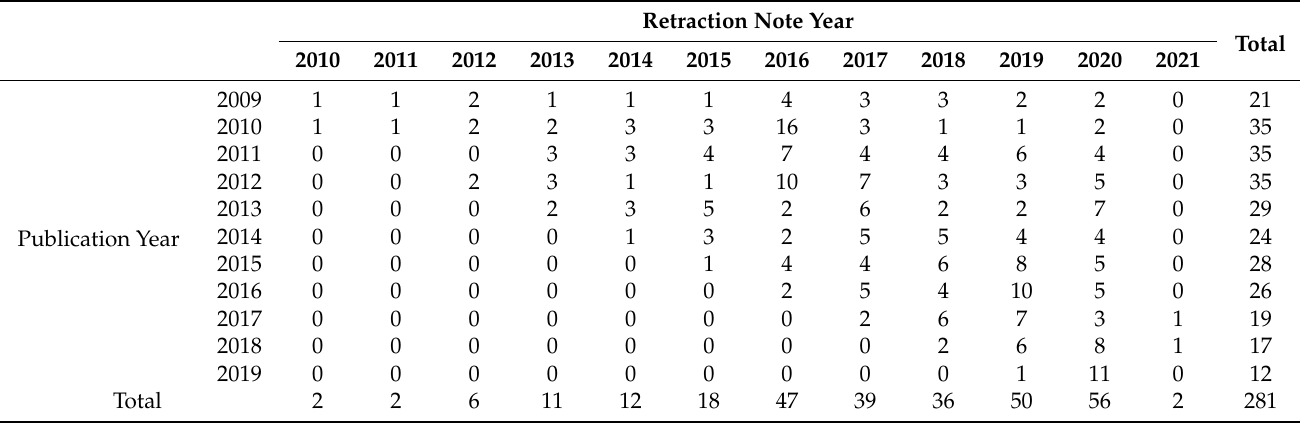
Table 7. Elsevier image